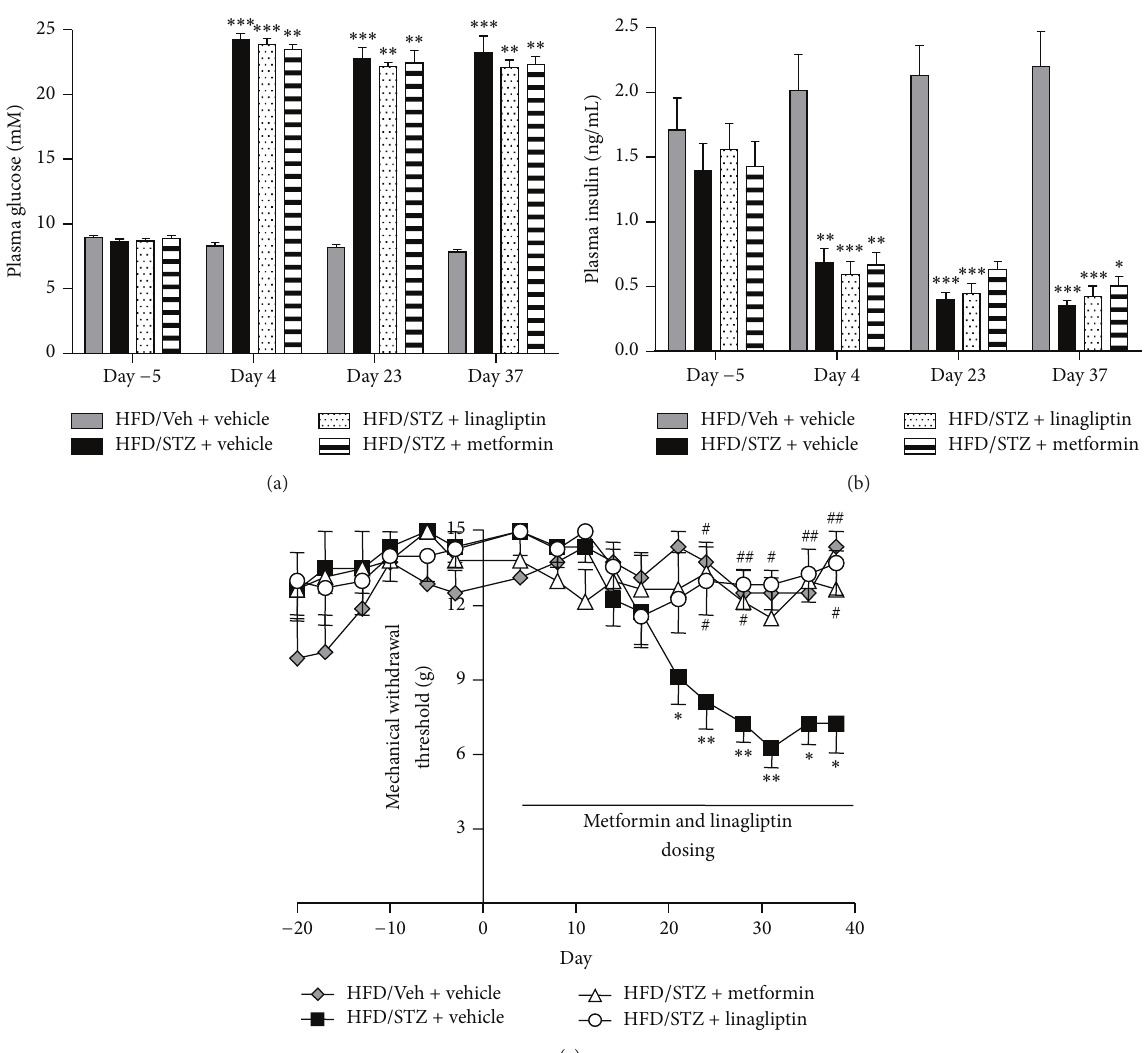
Figure 2: Effects of linagliptin and metformin on metabolic changes and mechanical withdrawal thresholds. Effects of linagliptin (3 mgkg −1 , p.o.; 𝑛 = 7 ) or metformin (200mgkg −1 , p.o.; 𝑛 = 6 ) given daily from day 4 onwards on (a) fasting plasma glucose, (b) fasting plasma